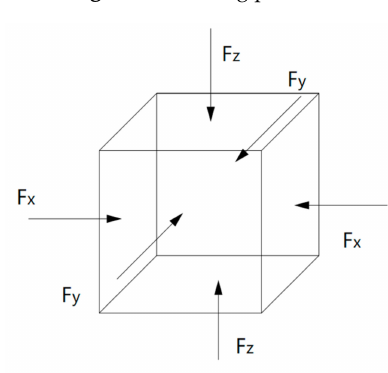
Figure 4. Loading process.